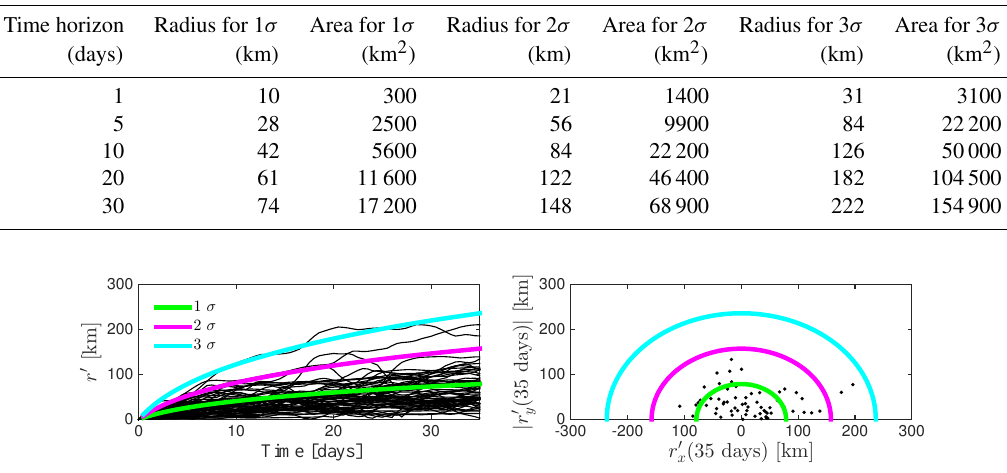
Figure 5. Time evolution of the norm of the fluctuating displacement r (cid:48) for every thousandth 35-day segments extracted from the IABP buoys tracks for the winters 1979–2011 (left). The solid lines in color indicate 1, 2 and 3 standard deviations of the fluctuating displacement, respectively. Illustration of search area after 35 days (right) estimated statistically from the IABP buoys dataset for the period